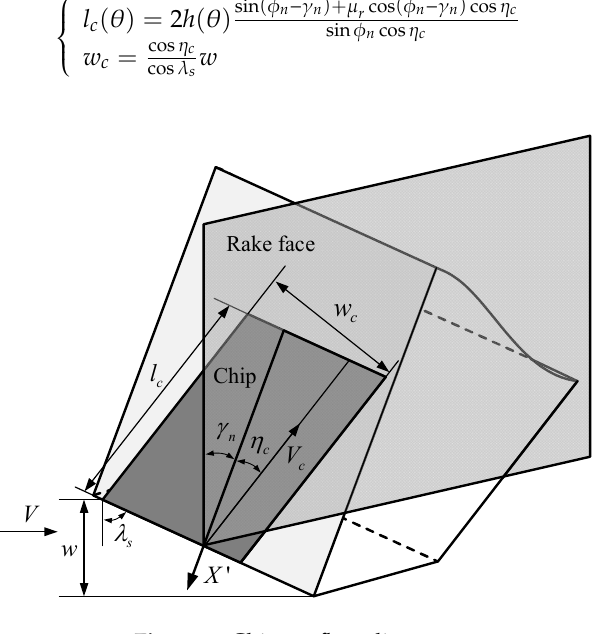
Figure 6. Chip outflow diagram.